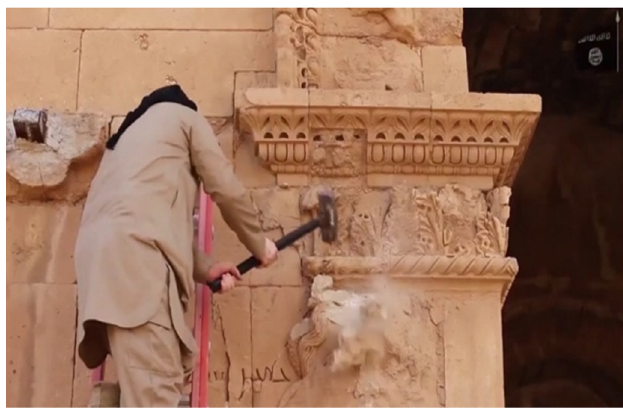
Fig. 2. ISIL militants have destroyed remains of the 2000-year- old city of Hatra, a well-preserved complex of temples south of Mosul [Associated Press].